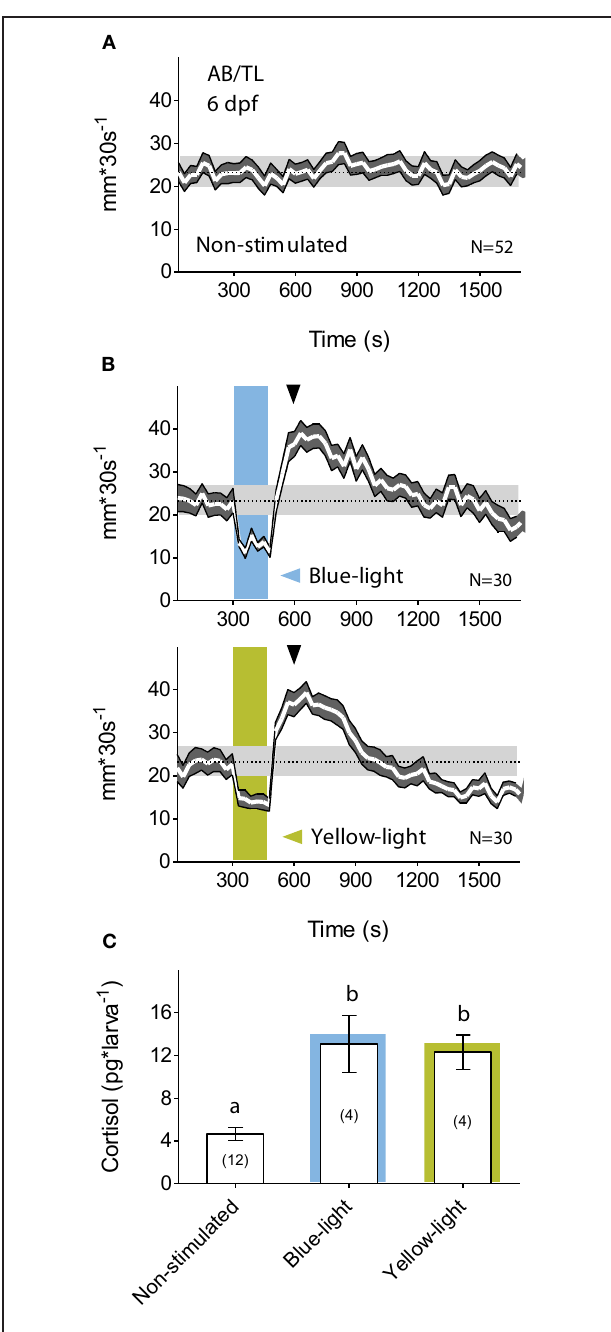
FIGURE 1 | A brief exposure to light is stressful for dark-adapted larvae. (A) Wild-type 6 dpf larval zebrafish display regular motion levels while swimming in darkness (overall mean ± S . E . M. shown as dotted line and gray background, respectively). (B) When dark-adapted for 15min, 6dpf larvae react to a 180s squared pulse of either blue- (top) or yellow-light (bottom) with reduced locomotion after the light-onset followed by increased locomotion after the light-offset. Afterward, locomotion decreases gradually until it reaches steady-state levels tens of minutes later (light-power: 2.8mW ∗ cm − 2 ; gray arrowheads indicate cortisol extraction times). (C) Such a brief exposure to either blue- or yellow-light increases whole-body cortisol level (lowercase letters indicate statistical differences among groups; sample size in